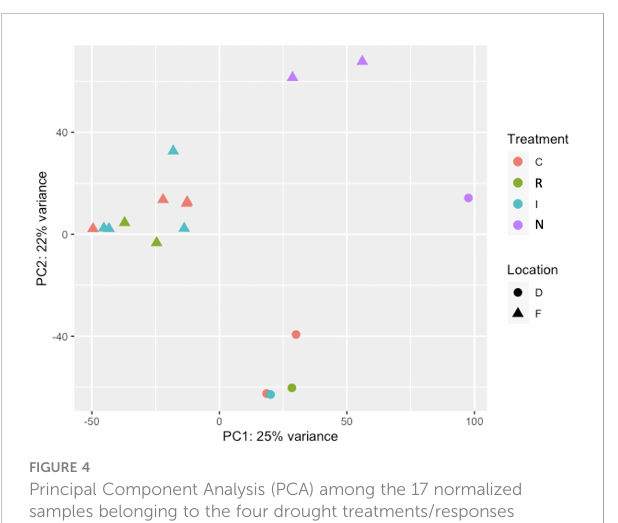
FIGURE 4 Principal Component Analysis (PCA) among the 17 normalized samples belonging to the four drought treatments/responses (Control C, immediate I, drought resilient R and non-resilient N) from Fiñana (F) and Dornajo (D) locations.